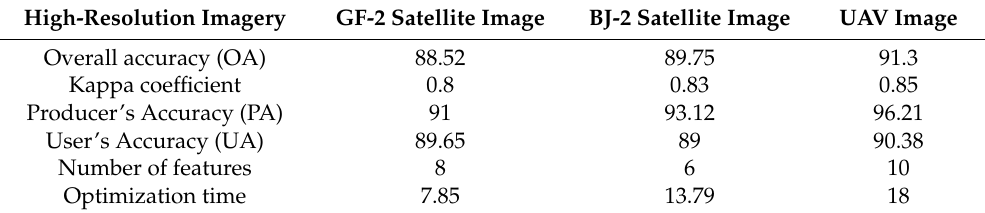
Table 4. Statistical analysis of the accuracy of proposed method for processing high-resolution imagery.